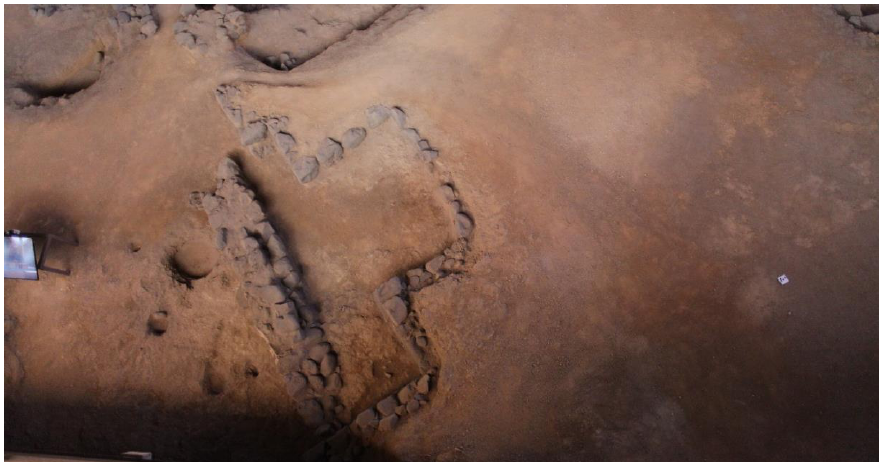
Figure 7. Nadiral image acquired from the pole system. On the right, a binary photogrammetric target can be seen.